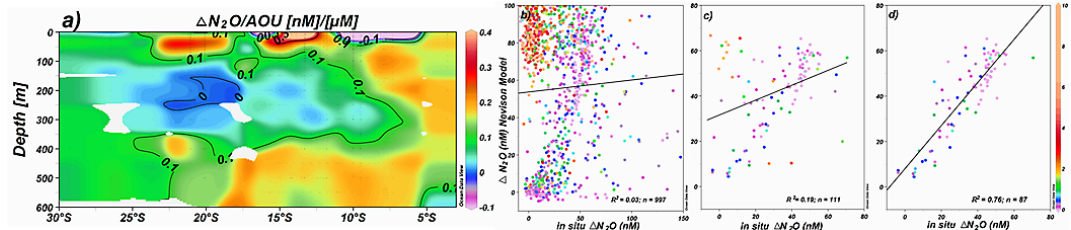
Fig. 2. (a) Meridional distribution of 1 N 2 O/AOU ratio along the ESP. (b–d) In-situ 1 N 2 O [nM] versus 1 N 2 O modeled by the Nevison et al equation: (b) including the entire eastern South Pacific; (c) including only measurements from water with oxygen levels above 8µM; and (d) 1 N 2 O from waters with oxygen levels above 8µM and nitrite below 0.75µM. The color indicates the nitrite concentration of each datum